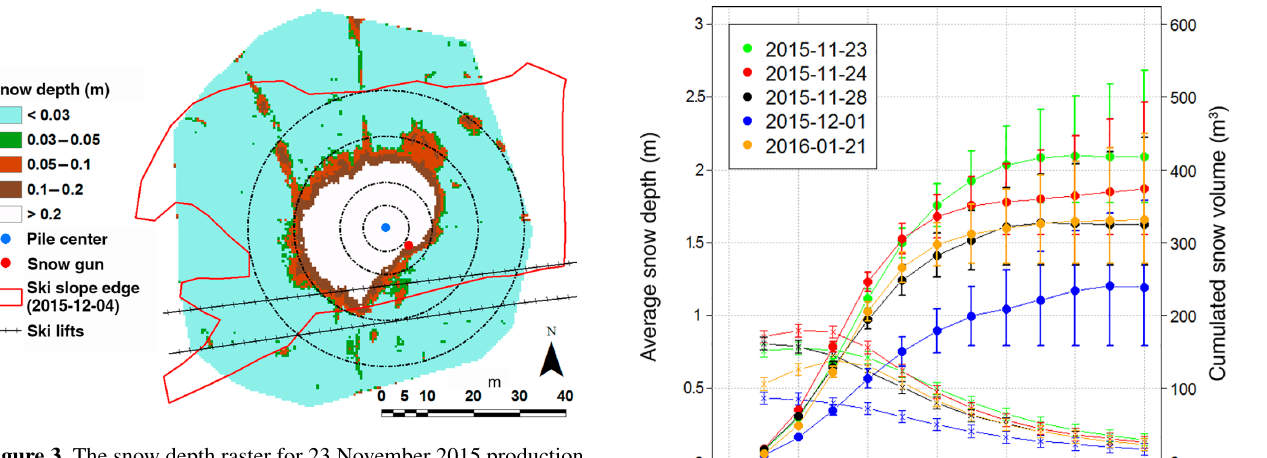
Figure 3. The snow depth raster for 23 November 2015 production session along with the positions of the snowgun, the center of the MM snow pile and the concentric circles of radius R = 5, 10, 20 and 30m. The edge of the ski slope on 4 December 2015 is also shown.